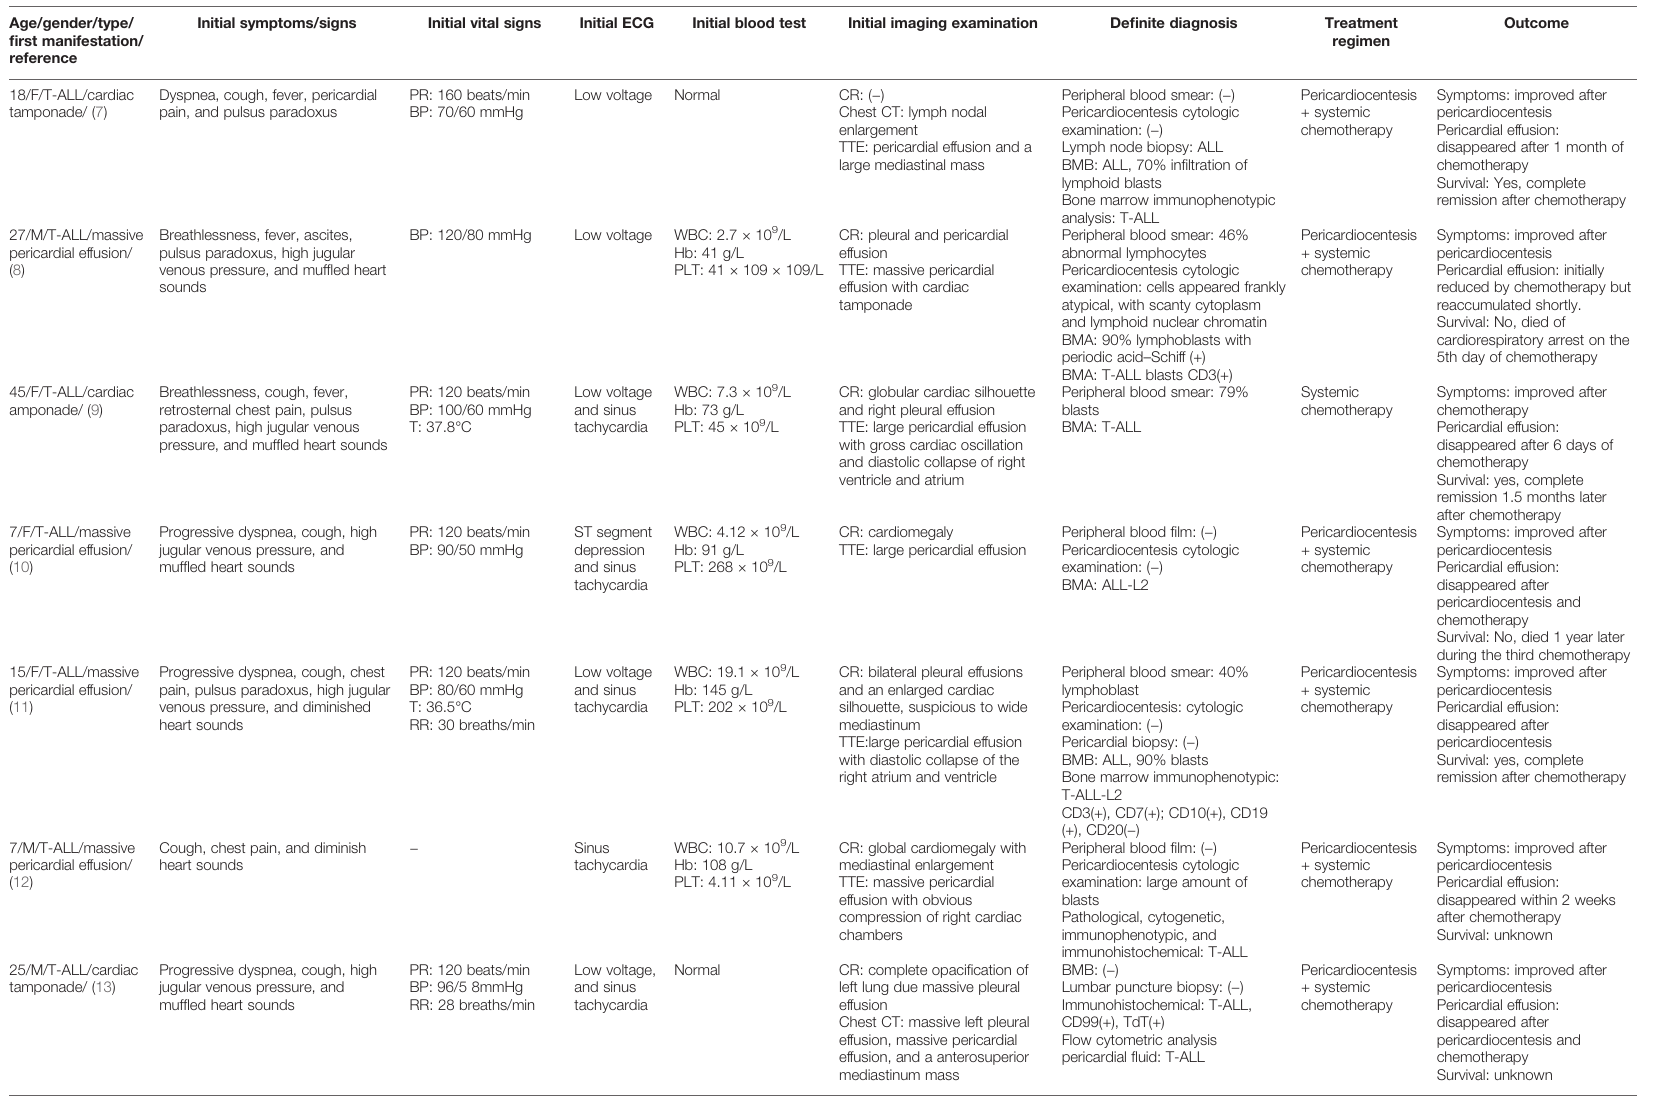
TABLE 1 | Cardiac tamponade as fi rst manifestation of acute lymphoblastic leukemia. Age/gender/type/ fi rst manifestation/